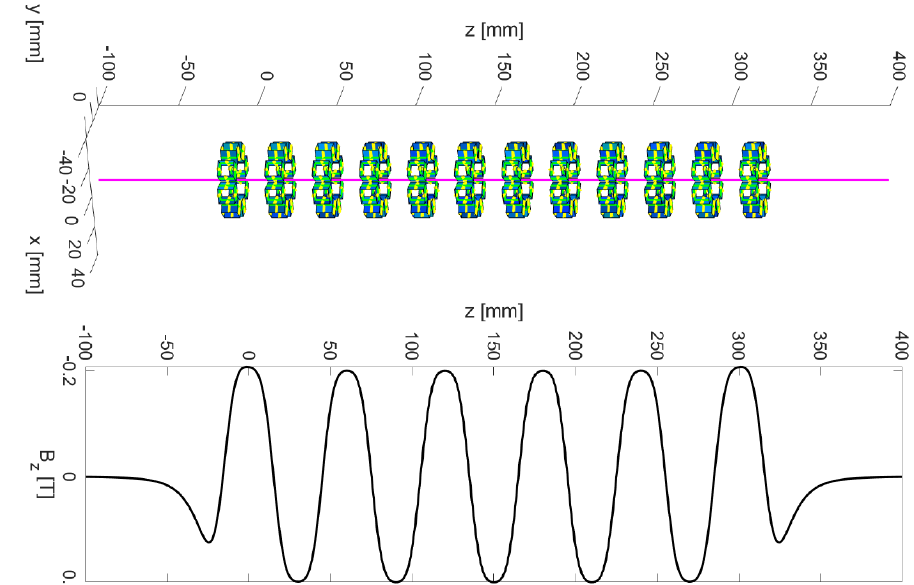
Figure 12. Assembling the six two-ring radial solenoids with alternating polarity, shown in the upper panel, created the longitudinal field B z shown in the lower panel. It has a larger focusing strength than the two-ring solenoid used in Figure 11 and can be used for higher-energy